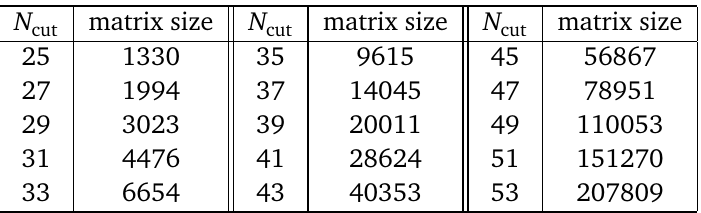
Table C.1: Matrix size vs.